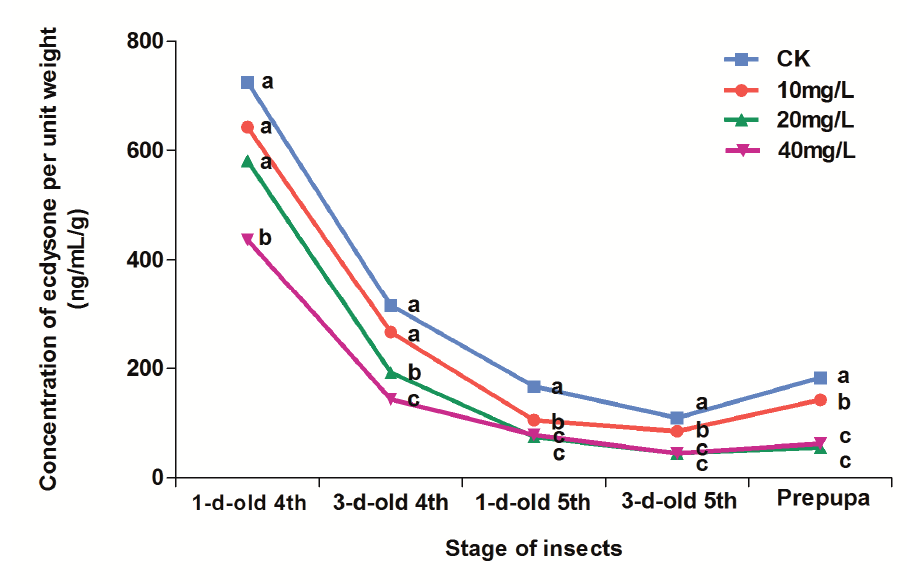
Figure 3. The concentration of ecdysone per unit weight of Spodoptera litura larvae or prepupae after treatment with different concentrations of total alkaloids. Bar (± SE) (4 replicates) followed by the same letter within a stage are not significantly different at p < 0.05 using Duncan’s multiple range test. CK: 70%